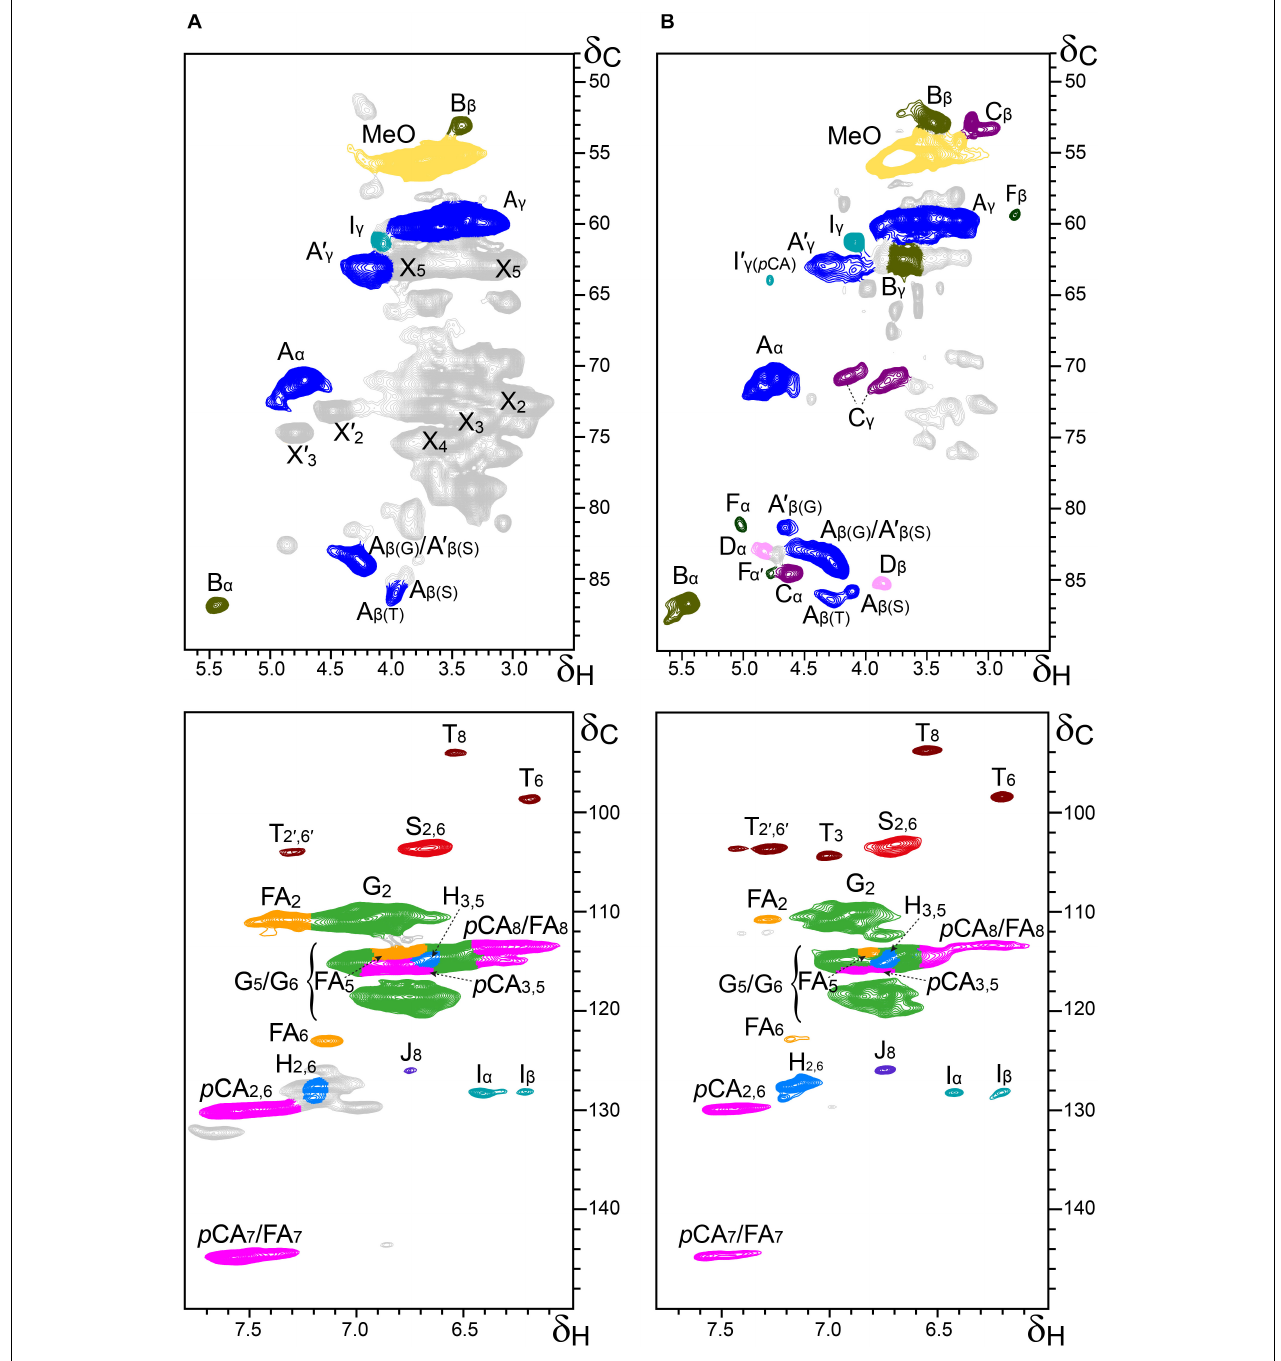
FIGURE 3 | Aliphatic-oxygenated ( δ C / δ H 48–90/2.5–5.7; top) and aromatic ( δ C / δ H 90–150/6.0–7.8; bottom) regions from the 2D-HSQC-NMR spectra (in DMSO- d 6 ) of the whole cell walls from rice husks (A) and its isolated MWL (B) . The main structures identified are drawn in Figure 5 . See Table 3 for signal assignments.